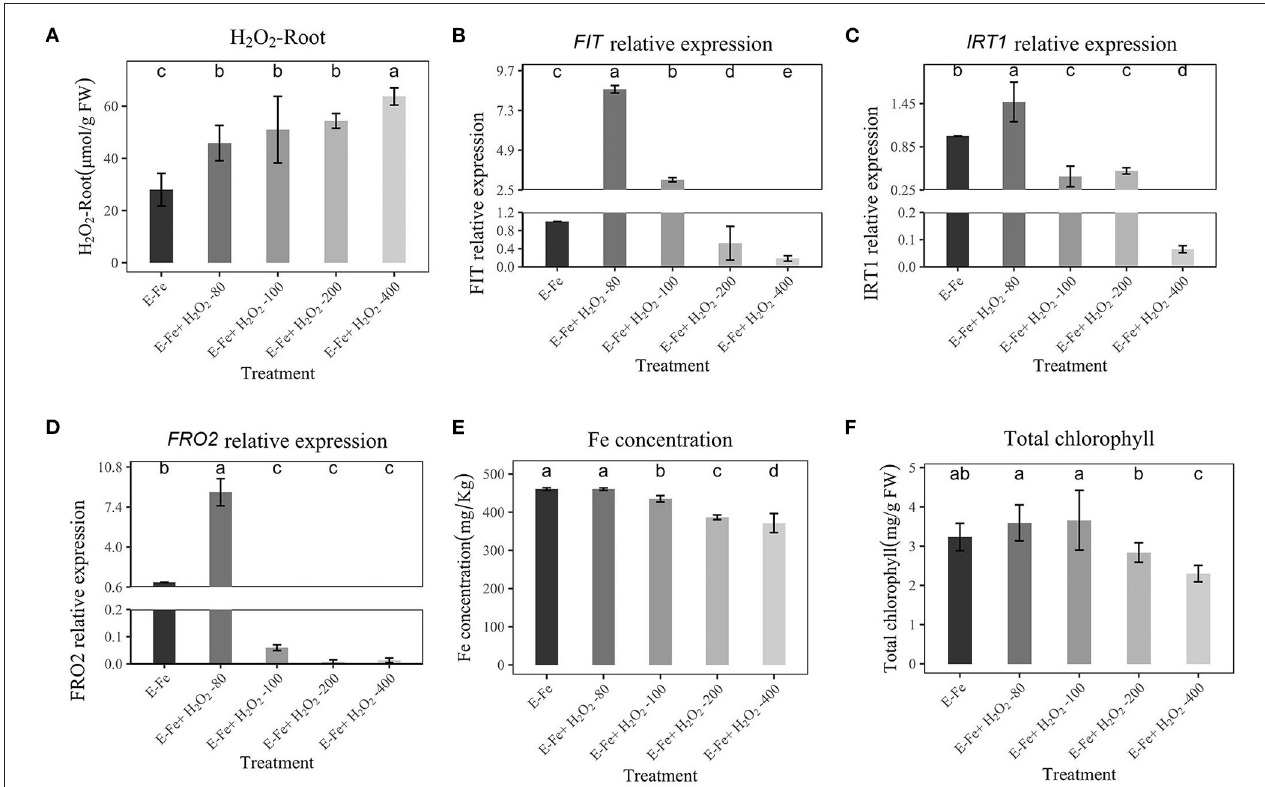
FIGURE 5 | Effects of Hoagland nutrient solution with different H 2 O 2 concentration on peanut after P. liquidambaris colonization under Fe-deficiency (A) : Effects of Hoagland nutrient solution with different H 2 O 2 concentration on H 2 O 2 content after P. liquidambaris colonization under Fe-deficiency. (B) : Effects of Hoagland nutrient solution with different H 2 O 2 concentration on FIT expression after P. liquidambaris colonization under Fe-deficiency. (C) : Effects of Hoagland nutrient solution with different H 2 O 2 concentration on IRT 1 expression after P. liquidambaris colonization under Fe-deficiency. (D) : Effects of Hoagland nutrient solution with different H 2 O 2 concentration on FRO2 expression after P. liquidambaris colonization under Fe-deficiency. (E) : Effects of Hoagland nutrient solution with different H 2 O 2 concentration on Fe concentration after P. liquidambaris colonization under Fe-deficiency. (F) : Effects of Hoagland nutrient solution with different H 2 O 2 concentration on total chlorophyll content after P. liquidambaris colonization under Fe-deficiency. Data and errors are mean ± SD, n = 6, and different letters indicate significant differences among treatments. p < 0.05. E = P. liquidambaris